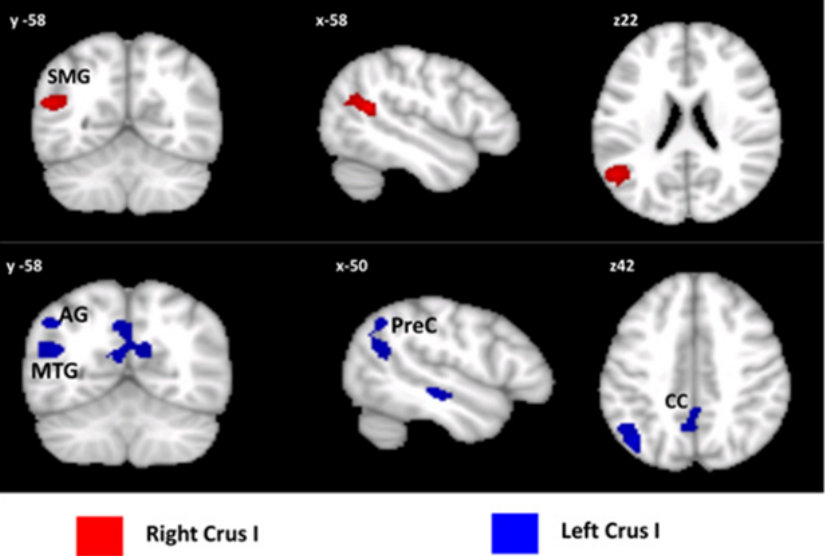
Figure 3. Patterns of cerebellar FC with the cerebral cortex. Seed-to voxel patterns of increased FC in bvFTD patients for right (in red) and left (in blue) Crus I. Coronal (y), sagittal (x), and axial slices (z) in the Montreal Neurological Institute space. Clusters of increased FC in the cerebral cortex were considered significant after correction for multiple comparisons (FWE-corrected p < 0.05). Images are shown in neurological convention. SMG: supramarginal gyrus; AG: angular gyrus; MTG: middle temporal gyrus; Prec: precuneus; CC: cingulate